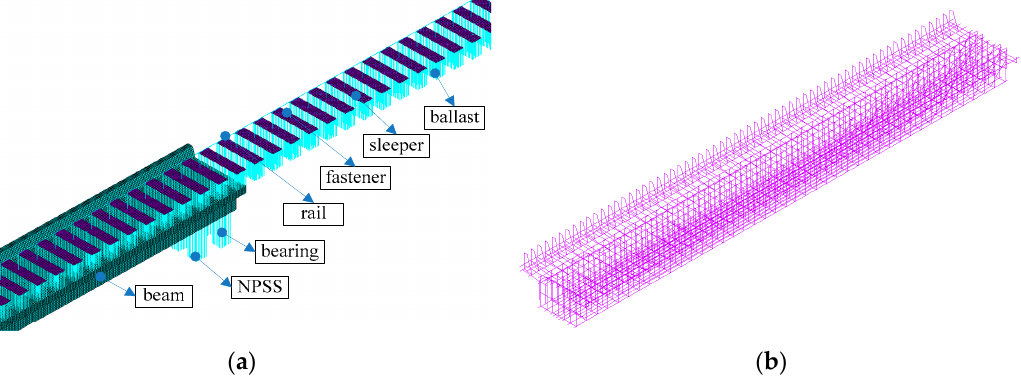
Figure 3. Refined calculation model. ( a ) Model outline; ( b ) skeleton frame of the steel bars.